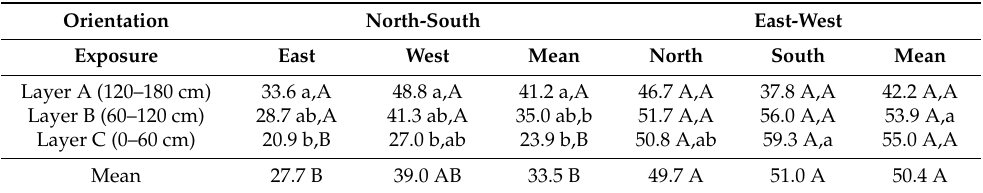
Table 8. Mean percentage fruit set (FS, %). The first letters denote significant differences between layers for a given exposure; the second letters denote significant differences between exposures for a given layer (SNK test). Lower case letters denote statistical differences with p = 0.05. Capital letters denote statistical differences with p = 0.01.